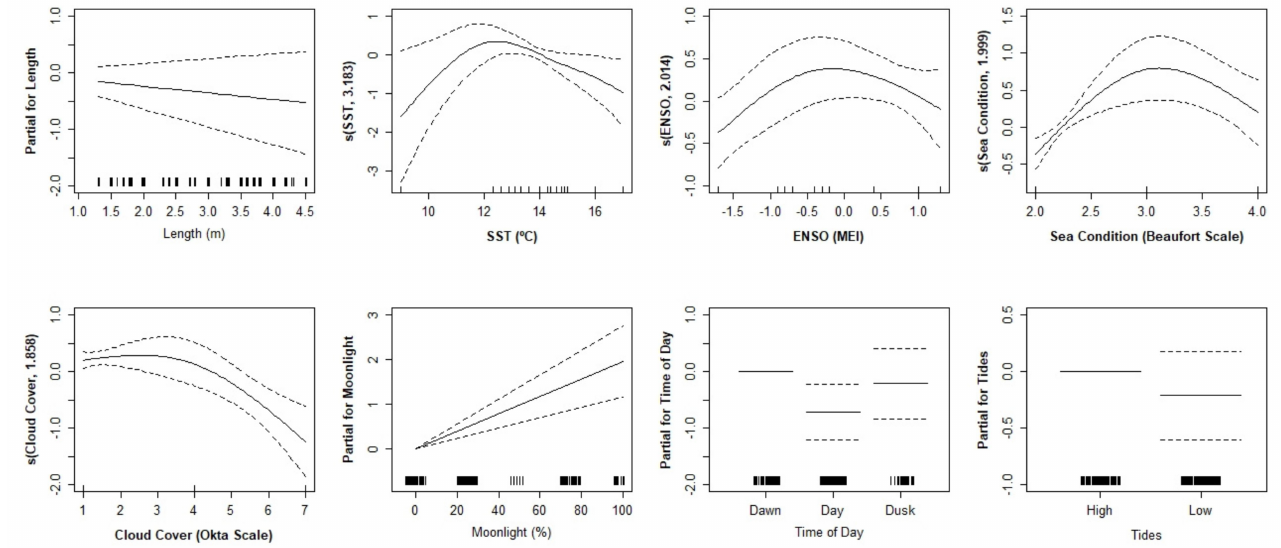
Figure 3. Generalised additive model functions of male white shark behaviour complexity in relation to the explanatory variables. Tick marks above the x-axis indicate the number of observations. The dashed lines represent the 95% confidence intervals of the spline functions. SST = sea surface temperature; ENSO = El Niño Southern